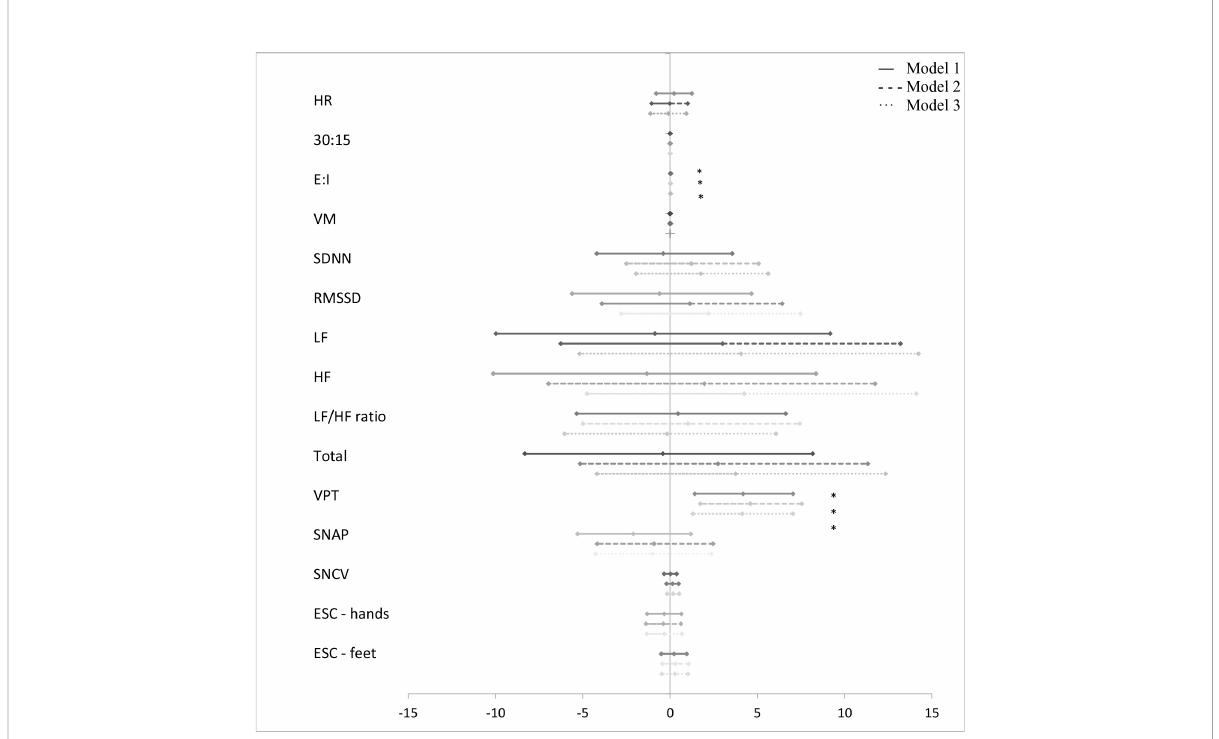
FIGURE 1 Forest plot of the associations between “ glycolytic dysfunction ” and measures of diabetic neuropathy. Results are presented as estimates and 95% con fi dence intervals. Estimates show the percentage change in the outcomes for an increase of one unit of “ glycolytic dysfunction ” . Studies with con fi dence interval crossing the vertical line are inconclusive. Model 1 adjusted for age and gender, model 2 adjusted as model 1 + diabetes duration and HbA 1c , and model 3 adjusted as model 2 + current smoking, total cholesterol, triglycerides, systolic blood pressure, and the use of beta blockers. CAN, cardiovascular autonomic neuropathy; HR, heart rate; 30:15, lying-to-standing test; E:I, deep breathing test; VM, Valsalva Manoeuvre; SDNN, standard deviation of normal-to-normal intervals; RMSSD, root mean square of the sum of the squares of differences between consecutive R-R intervals; LF, low-frequency power; HF, high-frequency power; DSPN, distal symmetric polyneuropathy; VPT, vibration perception threshold; SNAP, sural nerve amplitude potential; SNCV, sural nerve conduction velocity; ESC, electrochemical skin conduction. *p <